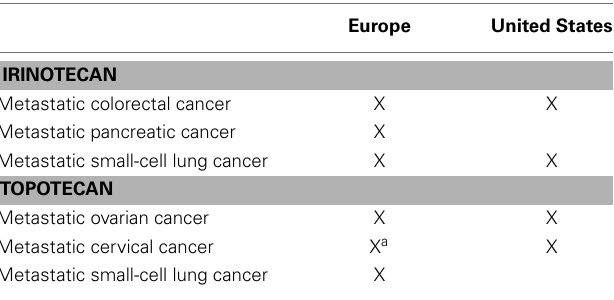
Table 1 |Approved and recommended indications for the use